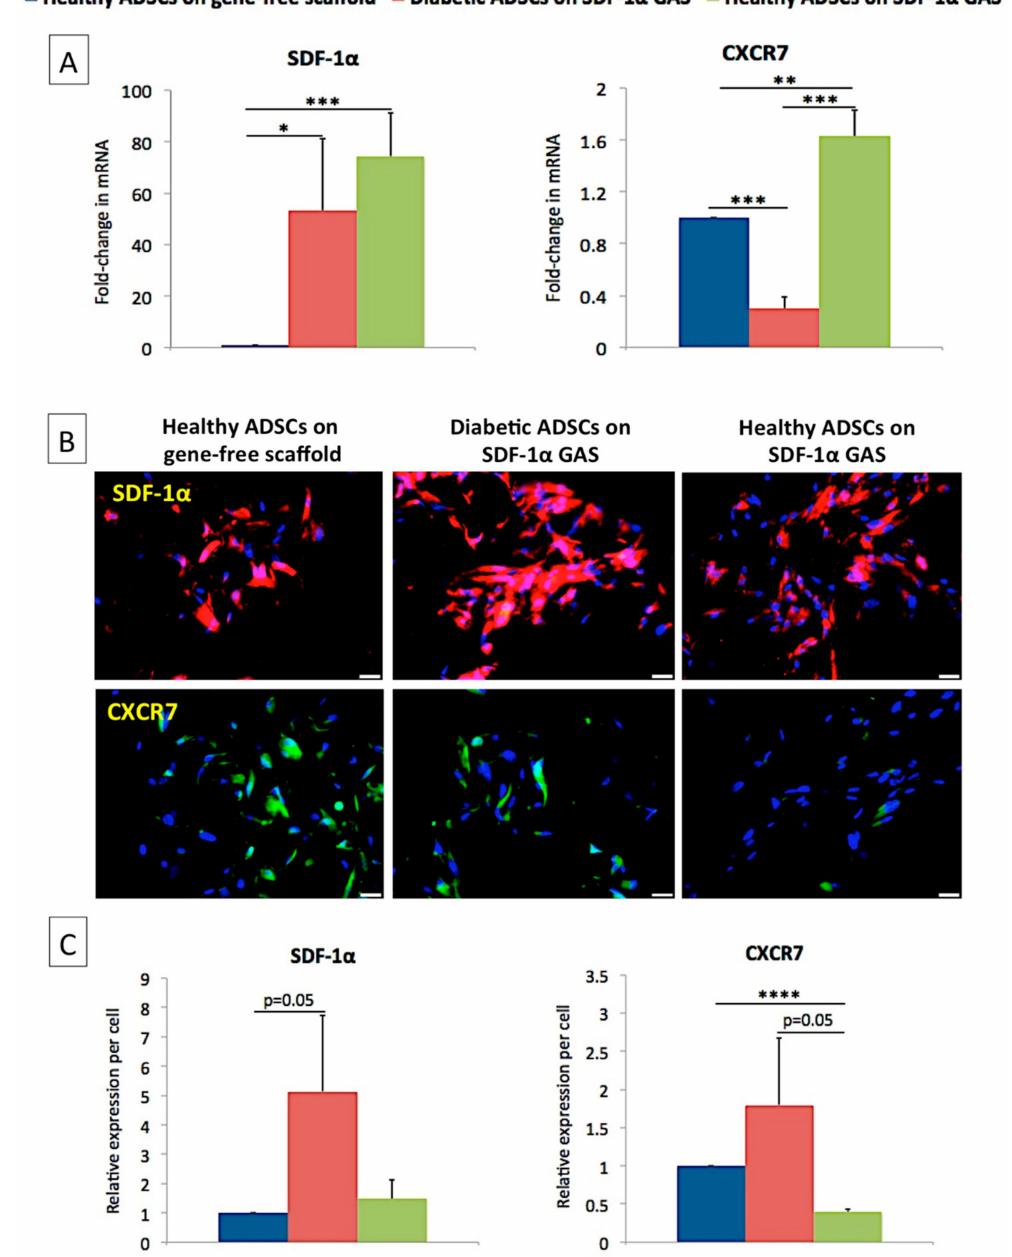
Figure 2. Impact of SDF-1 α gene-activated scaffold on the activation of SDF-1 α and its downstream signaling mediators in diabetic ADSCs. ( A ) SDF-1 α gene-activated scaffold caused the overexpression of SDF-1 α mRNA in both healthy and diabetic ADSCs. The overexpression of SDF-1 α mRNA had a minimal effect on the expression of CXCR7 mRNA in diabetic ADSCs, while it increased significantly in healthy ADSCs. ( B ) Immunofluorescence images showing the abundancy of SDF-1 α and CXCR7 in the ADSCs groups. ( C ) The diabetic ADSCs on the SDF-1 α gene-activated scaffold expressed the highest level of SDF-1 α and CXCR7 proteins, while healthy ADSCs displayed the weakest expression of CXCR7. *, **, *** and **** indicate statistical significance at p < 0.05, p < 0.01, p < 0.005 and p < 0.001, respectively. Data are presented as mean ± standard deviation ( n = 3). Scale bar 20 µ